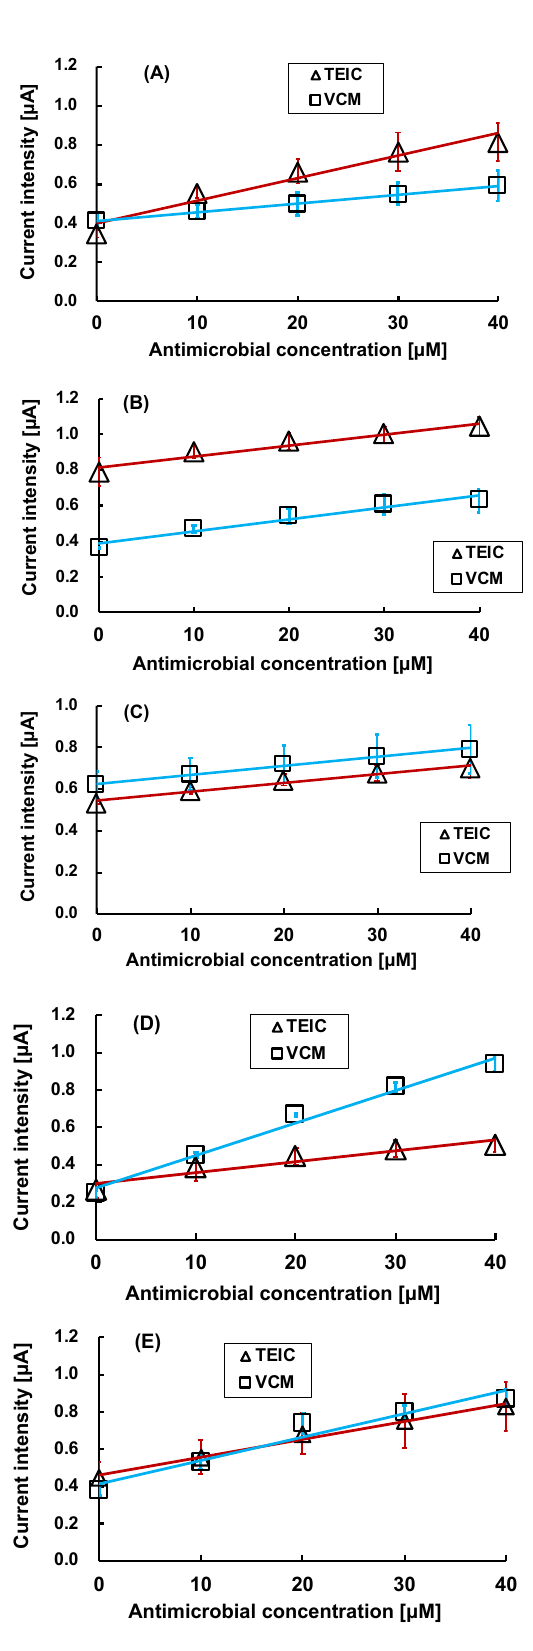
Figure 6. Relationship between VCM or TEIC concentration and current intensity at 0.80 V. ( A ) The unmodified electrode. ( B ) VF-MIP electrode. ( C ) VF-NIP electrode. ( D ) ACPF- MIP electrode. ( E ) ACPF-NIP electrode. Table 2. Sensitivity to VCM or TEIC at each electrode.